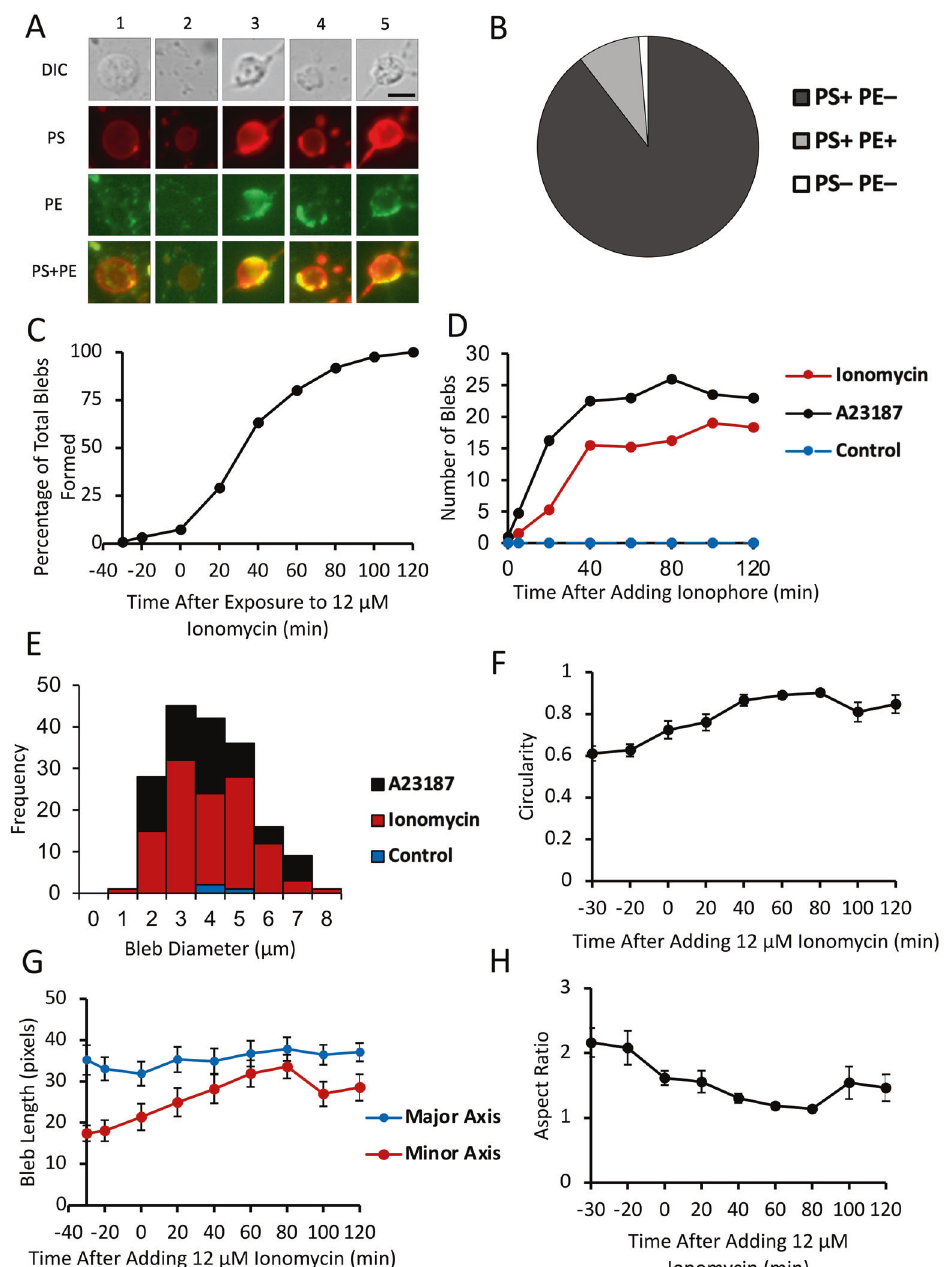
Fig. 2 Morphological characteristics, time dependence, and geometric aspects of bleb formation. A Examples of blebs with different staining patterns. 1: PS + PE – ; 2: PS + PE – Para-axonal PE + ; 3: PS + Half of Bleb PE + Para-axonal Staining + ; 4: PS + Half of Bleb PE + Para- axonal Staining – ; 5: PS + PE + . Scale bar 5 µm. B Classi fi cation of all blebs ( n = 220) observed in 5 cells exposed to 12 µM ionomycin, based on staining of externalized PS and PE. C Proportion of blebs formed before and after exposure to 12 µM ionomycin. D Mean number of